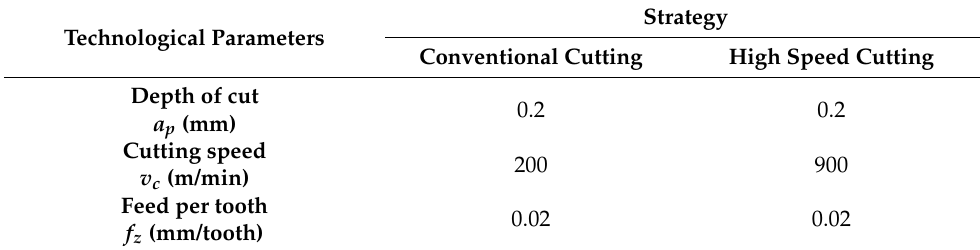
Figure 6. Stages of machining of the thin-walled element with walls arranged in a closed structure. The roughing was performed with the use of technological parameters corresponding to high performance cutting, such as the following: a e = 12 mm; a p = 4.94 mm; f z = 0.13 mm/tooth; v c = 502 m/min. Allowances of 0.2 mm at each side of the walls and the bottom were left for finishing machining. Finishing machining was performed with two variant operations with the use of conventional cutting and HSC (Table 3). Table 3. The technological parameters of finishing machining.